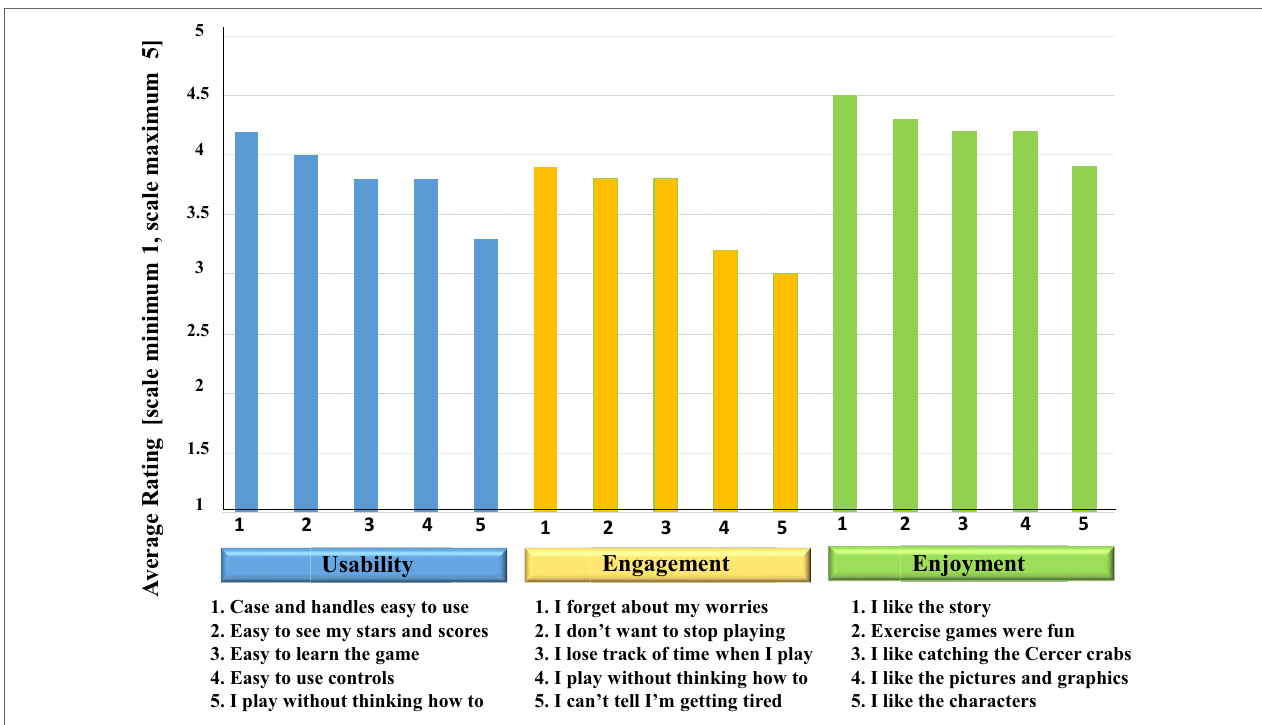
FigUre 10 | Mean responses of 10 pediatric cancer children to questions related to usability, engagement, and enjoyment of the prototype Empower Stars! video game. Ratings from the Likert scale from each of the three areas assessed were transformed to a numerical scale of 1–5. The mean rating scores for each question in the categories of usability, engagement, and enjoyment were then